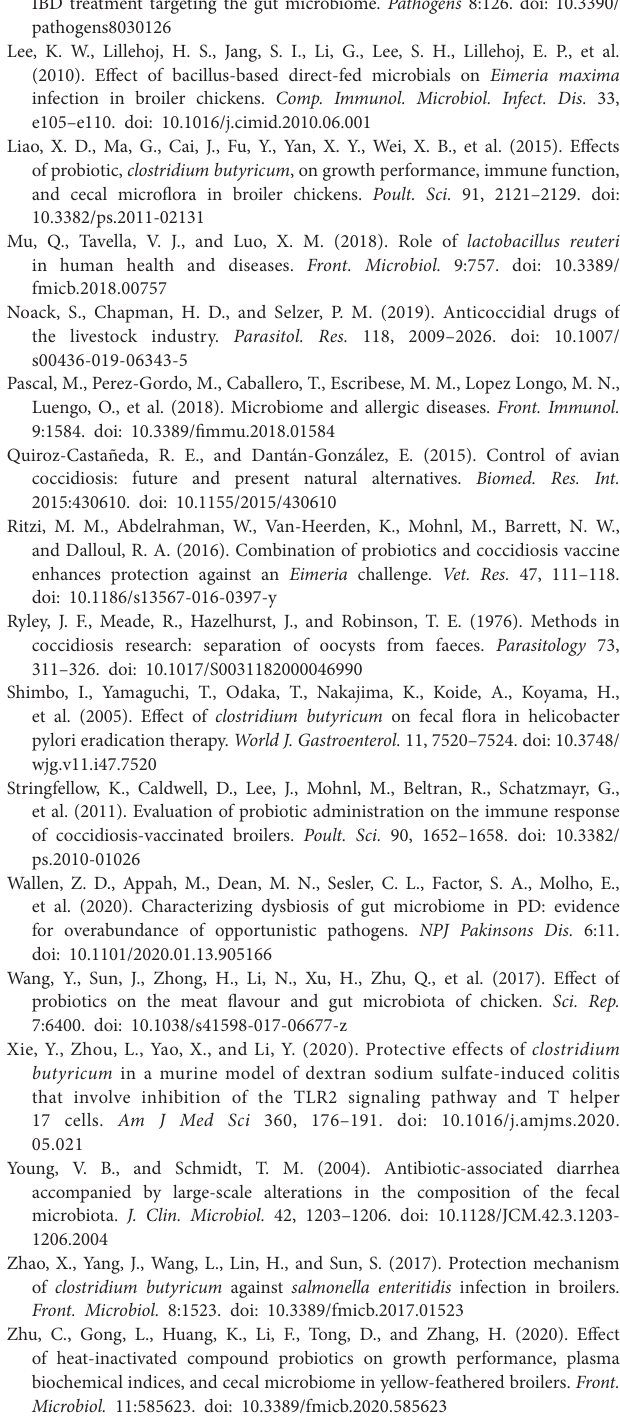
Supplementary Figure S4 | Comparison of intestine microbiome alpha diversity from samples pretreated with Clostridium butyricum and coccidiosis vaccine and then challenged with Eimeria sp. The alpha diversity indices, including observed taxa (A) , chao1 index (B) , Shannon diversity (C) , and inverse Simpson diversity (D) were visualized by boxplots. Alpha diversity was tested using the Kruskal–Wallis test with post hoc Dunn tests. The box plots show the median, and whiskers show 25 and 75% quartiles.